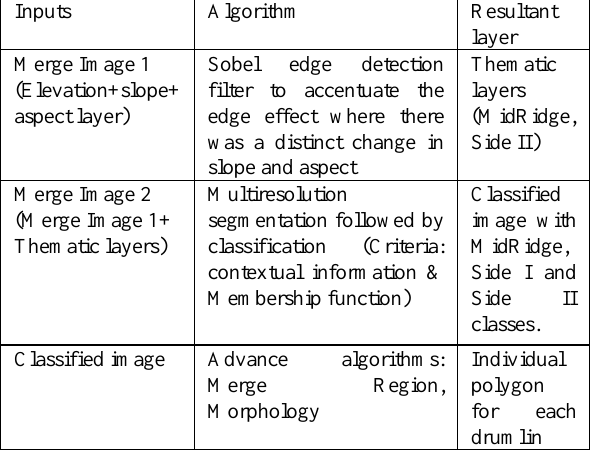
Table 1: Set of rules for automated extraction of terrestrial drumlins